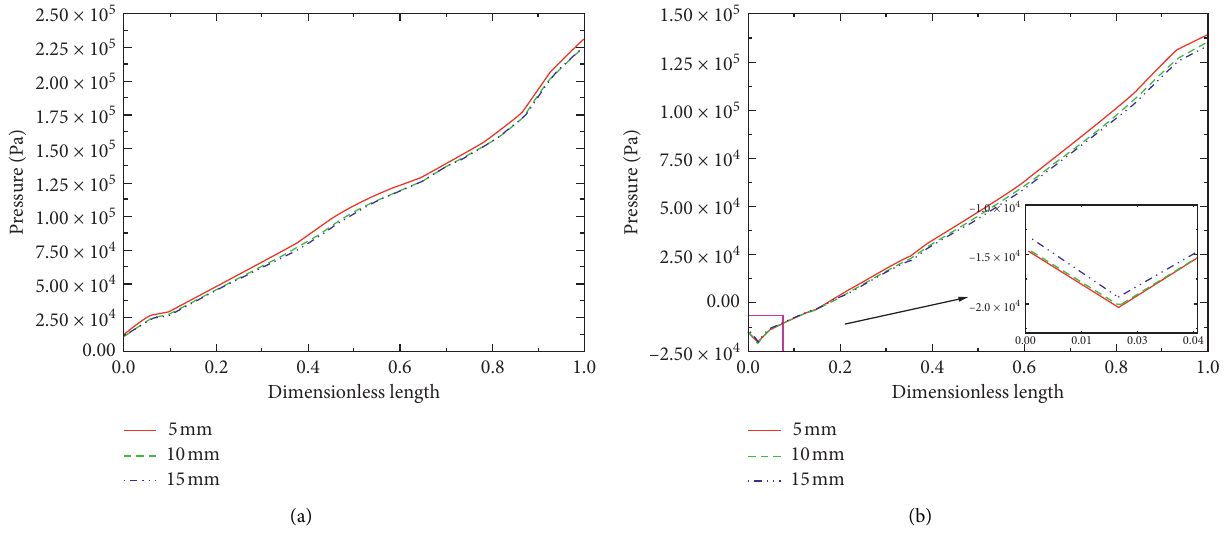
Figure 12: Pressure distribution of the impeller: (a) pressure surface and (b) suction surface.